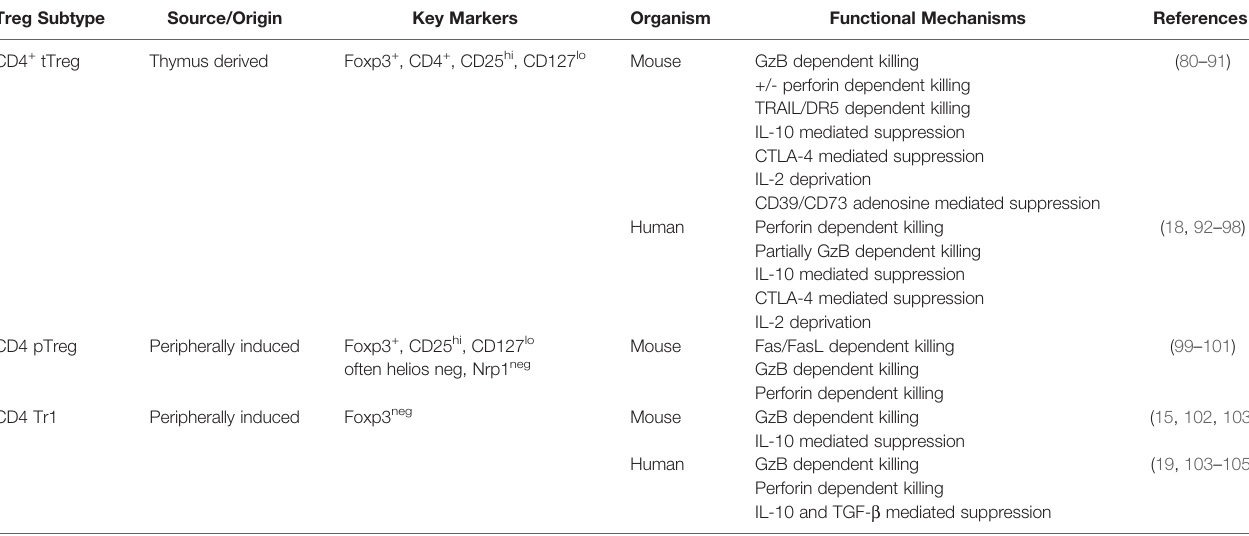
TABLE 1 | Immunosuppressive and cytotoxic killing mechanisms used by CD4 + Treg